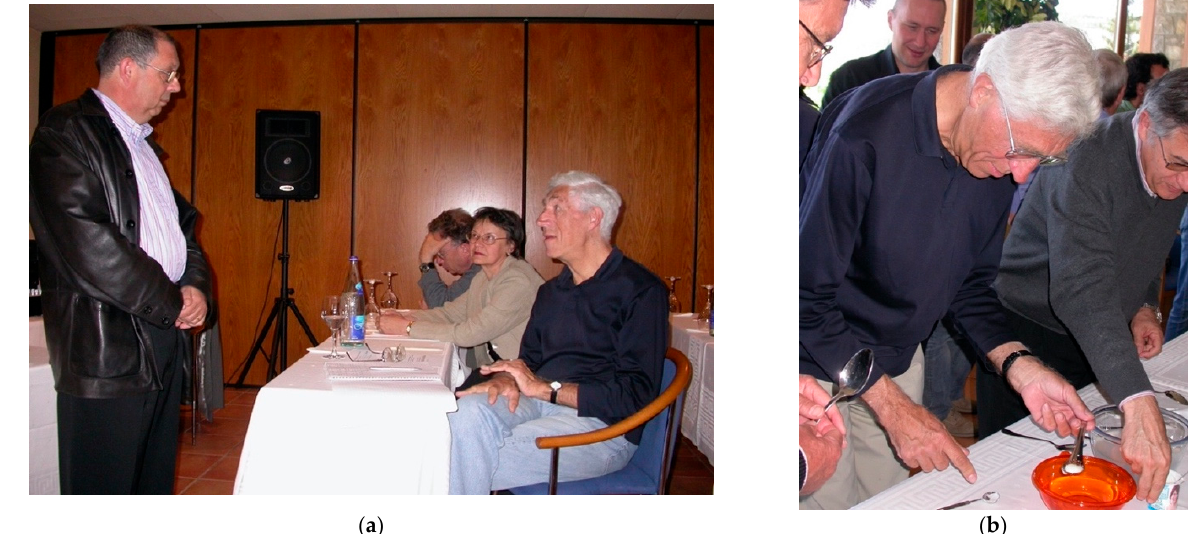
Figure 3. ( a ) Àngel Terron debates with Peter Day, with Magdolna and Istvan Hargittai in the background, at NoSIC ‐ 2, 31 May 2006; ( b ) Peter Day performs the spherification of a teaspoonful of yoghurt at NoSIC ‐ 2, surrounded by Rolf Saalfrank, Mario Ruben and Oriol Rossell. Prullans, 1 June 2006. Photos: S. Alvarez.